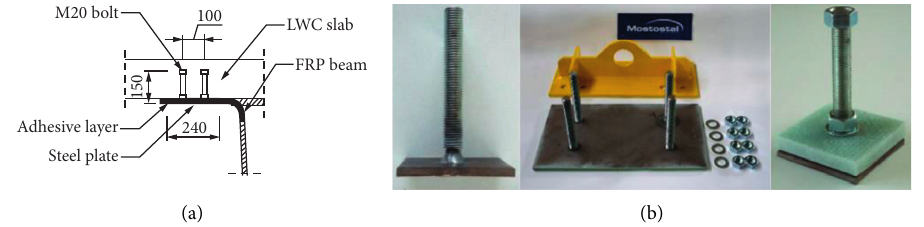
Figure 27: Concept and elements of the novel shear connection